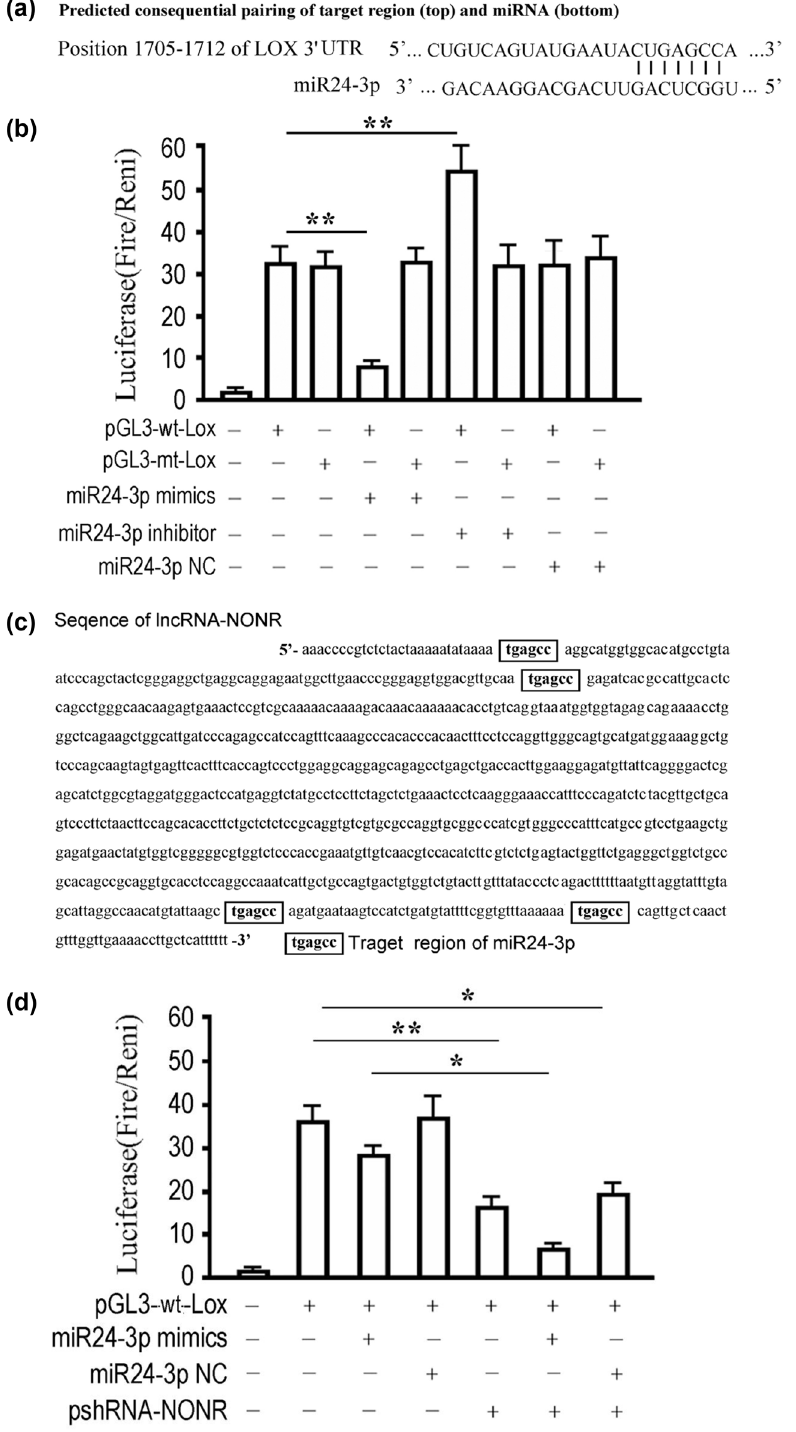
Figure 2: lncRNA NONRATT013819.2 competitively binds miR24 - 3p to reduce the binding inhibition of miR24 - 3p on lox. ( a ) The binding sites of miR24 - 3p and lox gene in the 3 ′ UTR, which were predicted with TargetScan software. ( b ) Dual - luciferase assay veri fi ed the interaction of miR24 - 3p and lox . The relative activity of luciferase in each group was detected at 48 h after co - transfection. ( c ) The analysis of binding site between NONRATT013819.2 sequence and miR24 - 3p. ( d ) In TGF - β 1 - activated HSCs, the e ff ect of silencing NONRATT013819.2 on the interaction of miR24 - 3p with lox was detected by dual - luciferase assay. The relative activity of luciferase in each group was detected at 48 h after co - transfection. The results were expressed as the mean ± SD from three independent experiments, * P < 0.05, ** P <